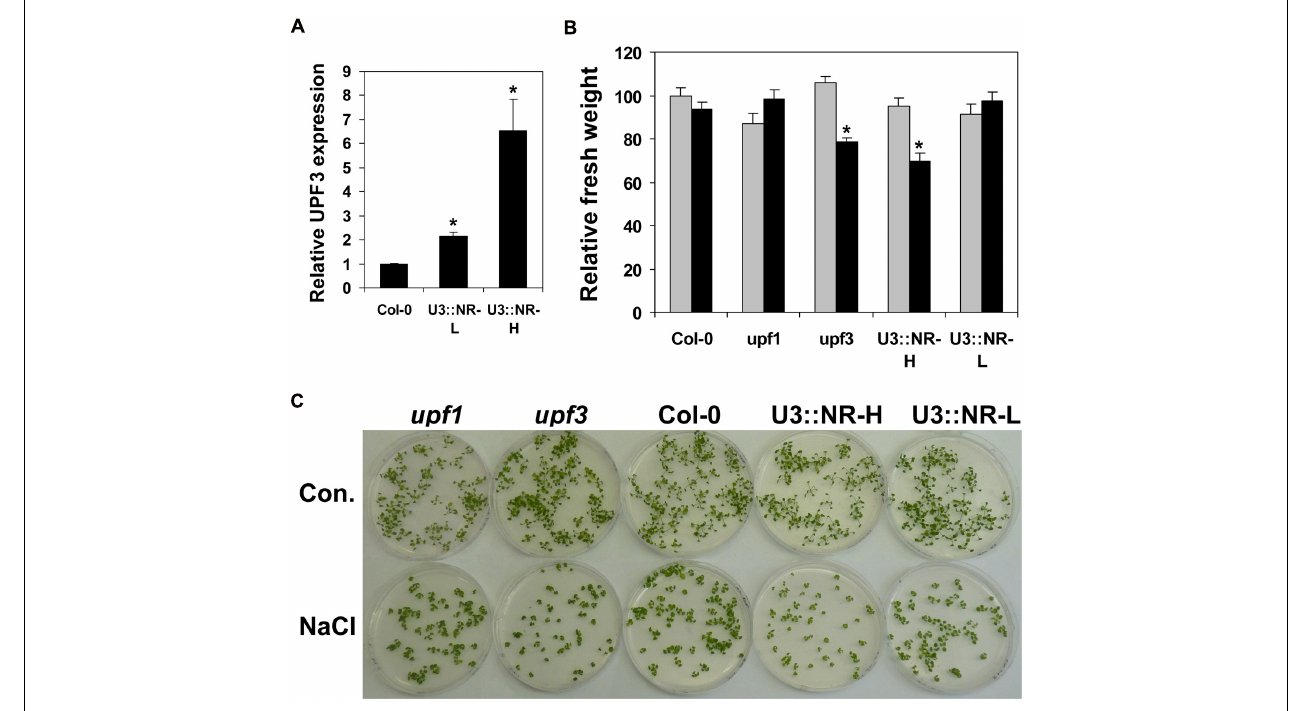
FIGURE 6 | Plants with deficient or highly excessive UPF3 expression exhibit impaired salt tolerance. In order to compare salt tolerance, WT (Col-0) plants, upf1-5 and upf3-1 mutants, as well as plants overexpressing UPF3 under the control of its own regulatory sequences (U3::NR-L and U3::NR-H), were germinated in the absence or presence of NaCl. (A) qRT-PCR analysis showing the extent of UPF3 overexpression in each of the two homozygous transformed plants (U3::NR-L and U3::NR-H) used in this experiment. Samples from four biological replicates (four different plates including ∼ 50 plants each), each analyzed using three technical replicates, were used for determination of UPF3 transcript content in each plant type, and data were normalized to UPF3 expression in WT plants. Error bars represent the SE. An asterisk indicates a significant difference ( p < 0.05) between the WT and the transformed plant, as determined by Student’s t -test. (B) Each column represents the mean fresh weight of 10 biological replicates grown on the control medium (gray columns) or on plates containing 100 mM NaCl (black columns). Each replicate was the average fresh weight of a single plant determined according to the weight and number of 2-week-old plants grown in a single plate (thus, each column shows the average weight of about 500 plants grown in 10 plates). It was verified that all seeds germinated at the same time. All data were normalized to the control treatment of WT plants. Error bars represent the SE. An asterisk indicates a highly significant difference ( p < 0.001) between the control and the NaCl treatment of the same plant genotype, as determined by Student’s t -test. (C) Representative plates at the time of